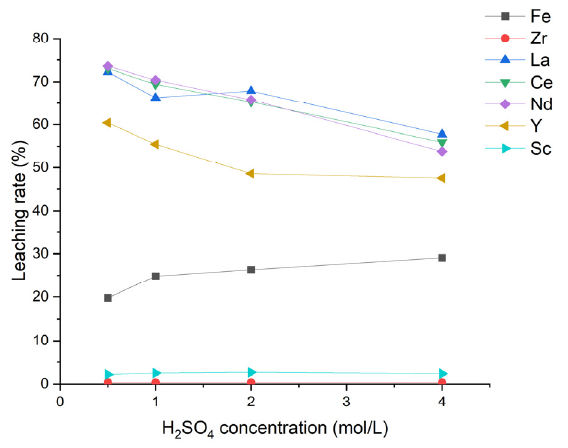
Figure 5. Leaching rate of iron, zirconium, lanthanum, cerium, neodymium, yttrium, and scandium, varying the acid concentration. Experimental conditions: 100 mL of H 2 SO 4 ; solid-liquid ratio = 1/10; T = 25 °C; t = 8 h; stirring speed = 200 rpm.